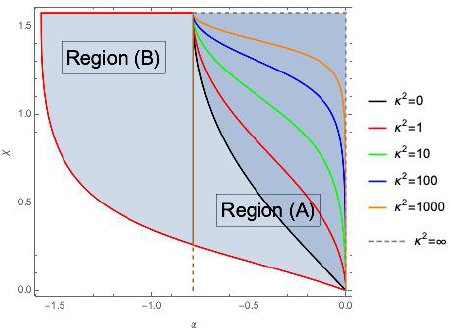
Figure 4. The coloured curves inside the darker region correspond to di(cid:11)erent values of (cid:20) 2 . The allowed region for m for (cid:12)xed value of (cid:20) 2 is the one on the left of the relevant coloured curve. The region becomes larger when we increase the